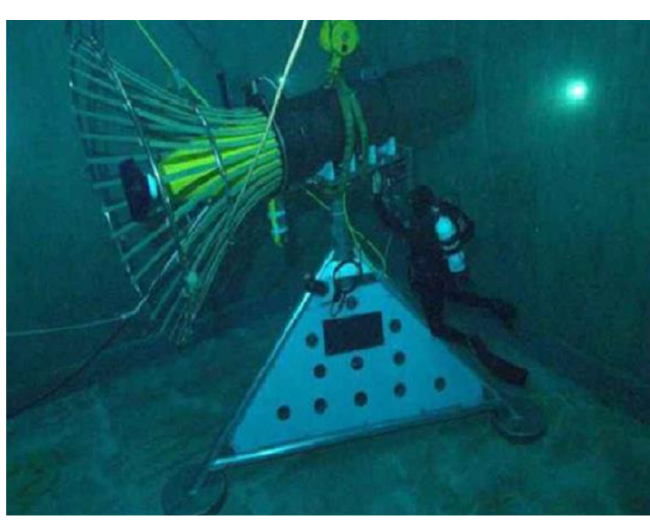
Figure 6. Bluefin underwater docking base station.